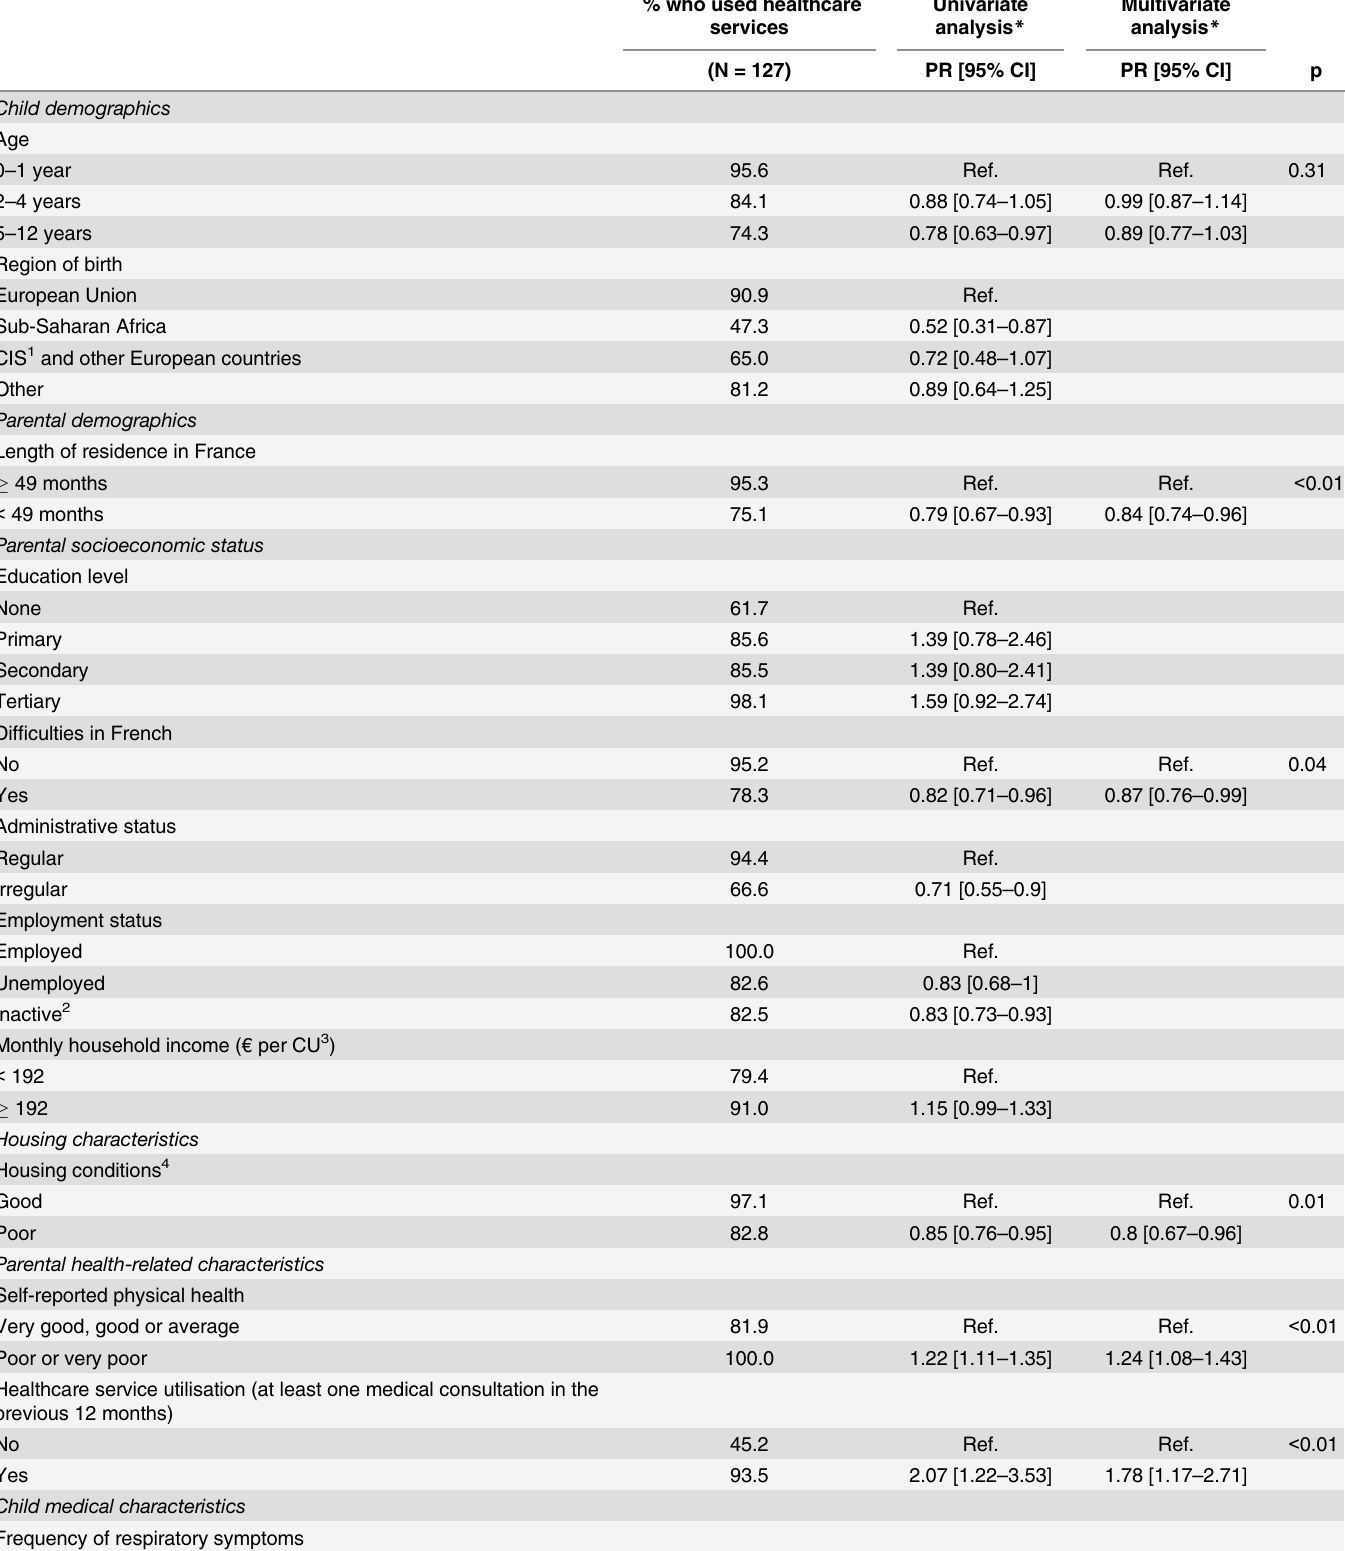
Table 4. Factors associated with healthcare service utilisation — univariate and multivariate